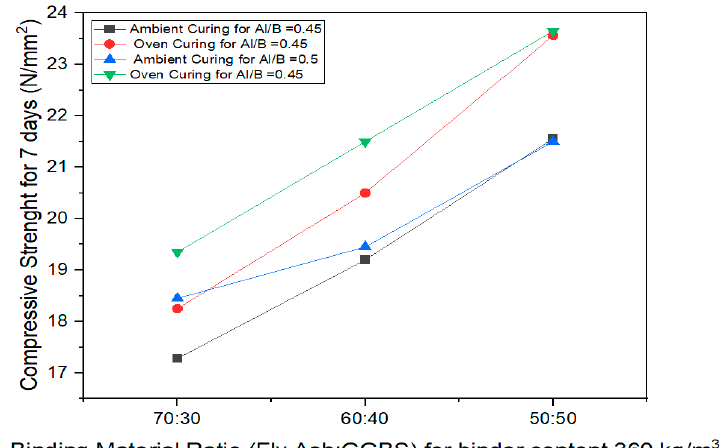
Figure 10. Compressive strength of GPC of 360 kg/m 3 for 7 days.